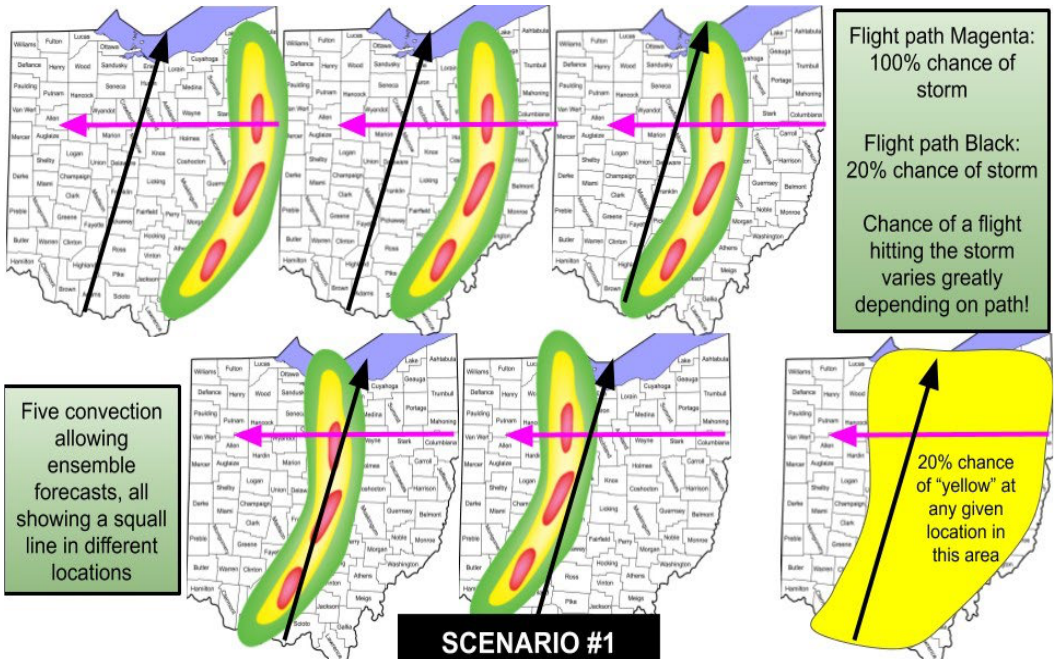
Figure 25. Five hypothetical ensemble convection forecasts, with two hypothetical flight paths. Despite there being a 20% chance of convection at a single point in time over a large area, one flight path has a 100% chance of being impacted by convection due to the ensemble certainty in existence and orientation of convection.